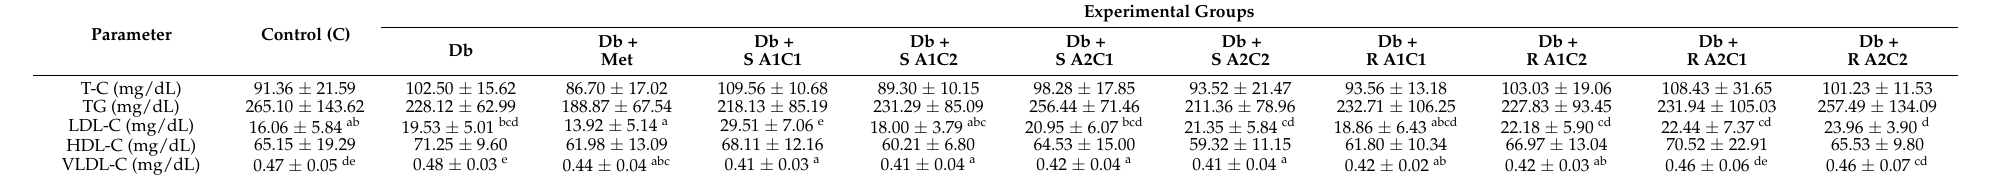
Table 3. Effects of the diet and combined SG, L-Arg, and Cr(III) supplementation on lipid metabolism indices in